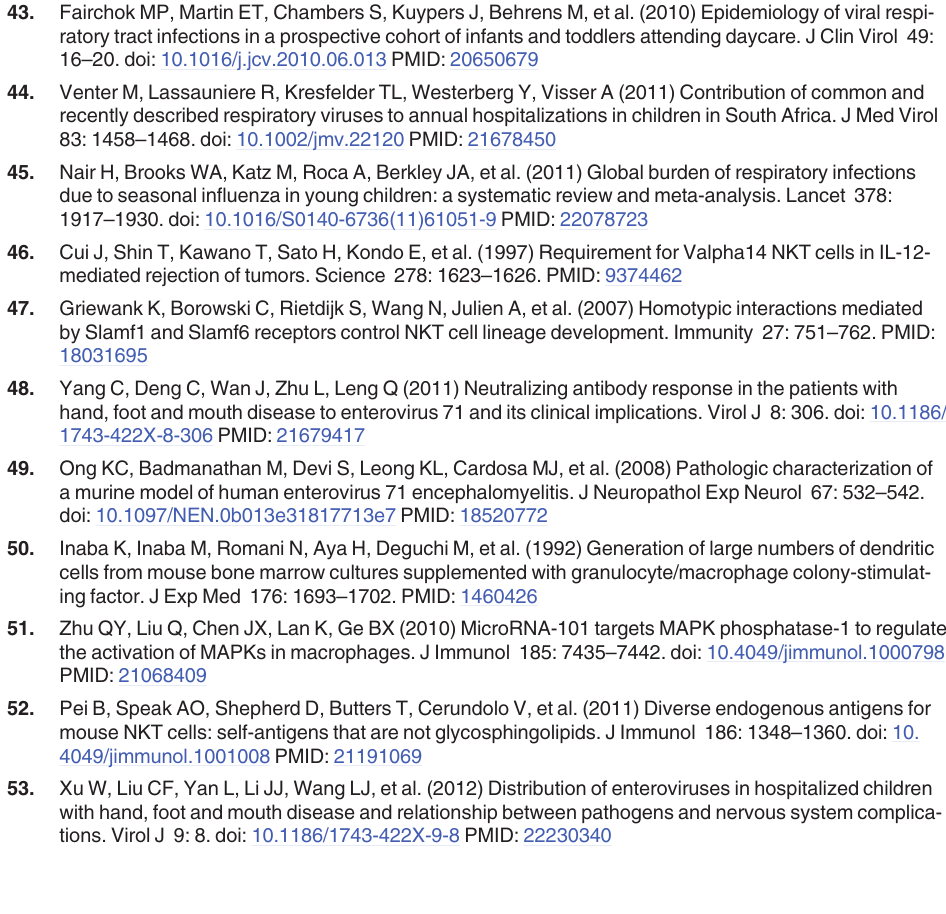
PLOS Pathogens | DOI:10.1371/journal.ppat.1004613 January 23,